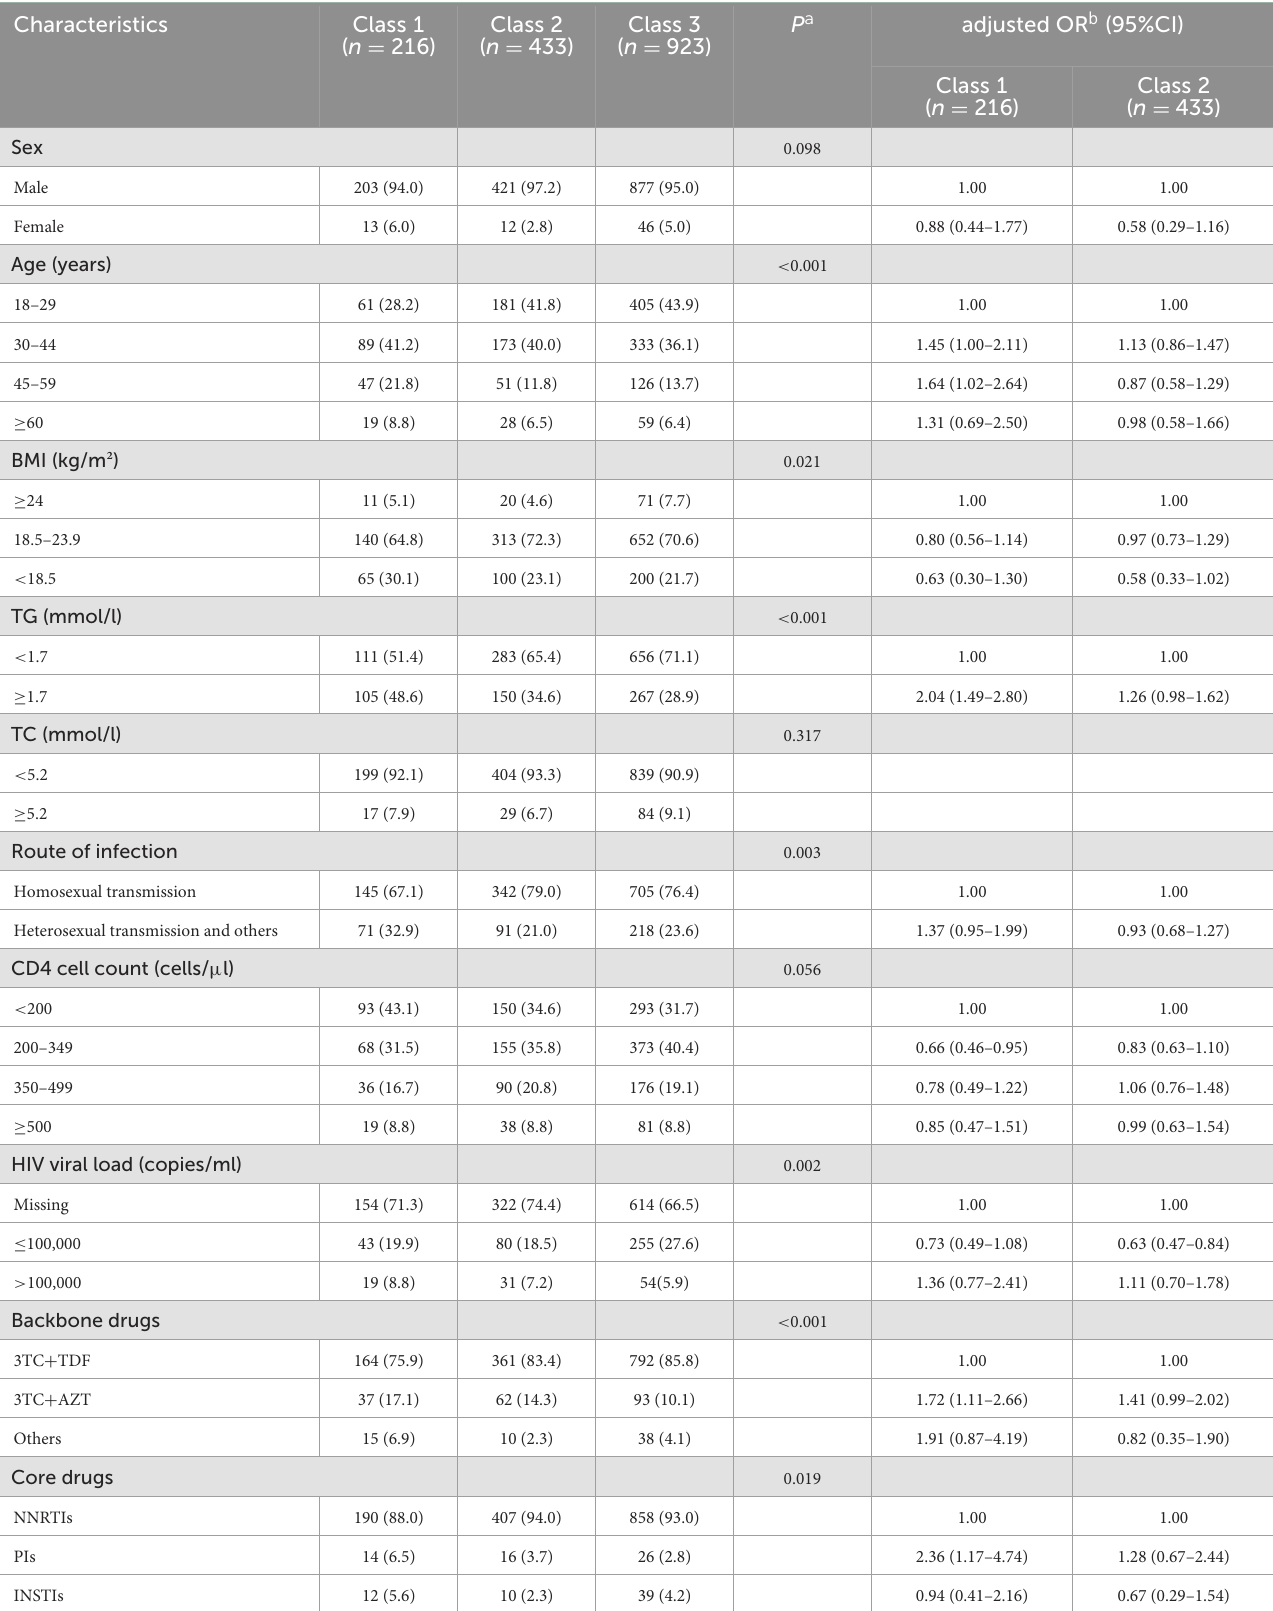
TABLE 3 Baseline characteristics of participants among three TG and TC dual-trajectory